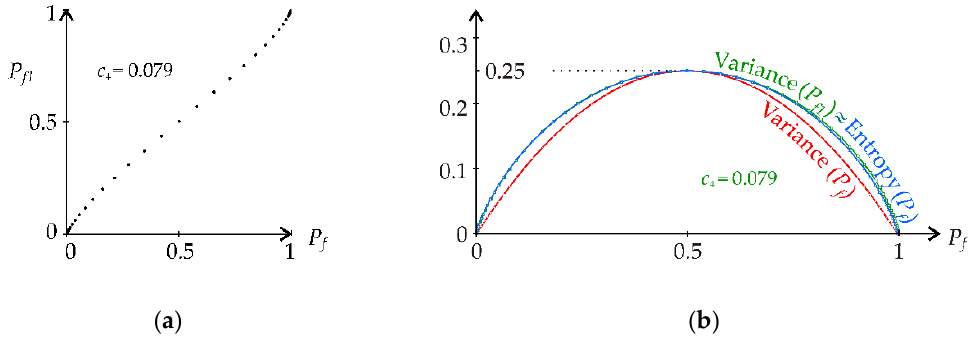
Figure 14. Comparison of P f and P f 1 for constant c 4 = 0.079: ( a ) P f 1 from Monte Carlo simulations using steps of μ A ; ( b ) variance and entropy for P f and P f 1 .